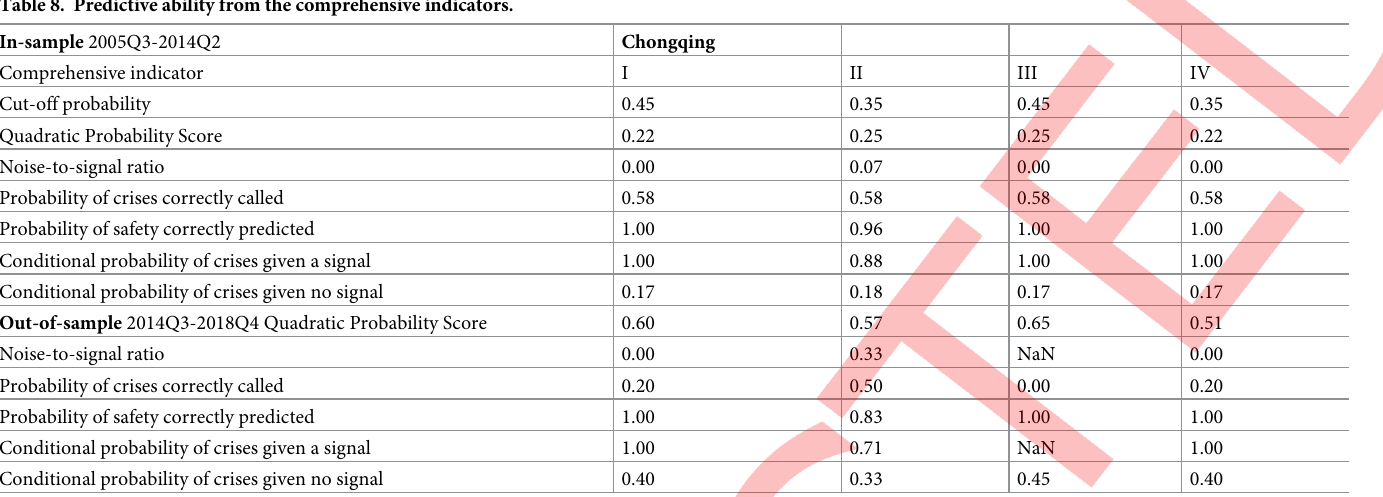
Table 8. Predictive ability from the comprehensive